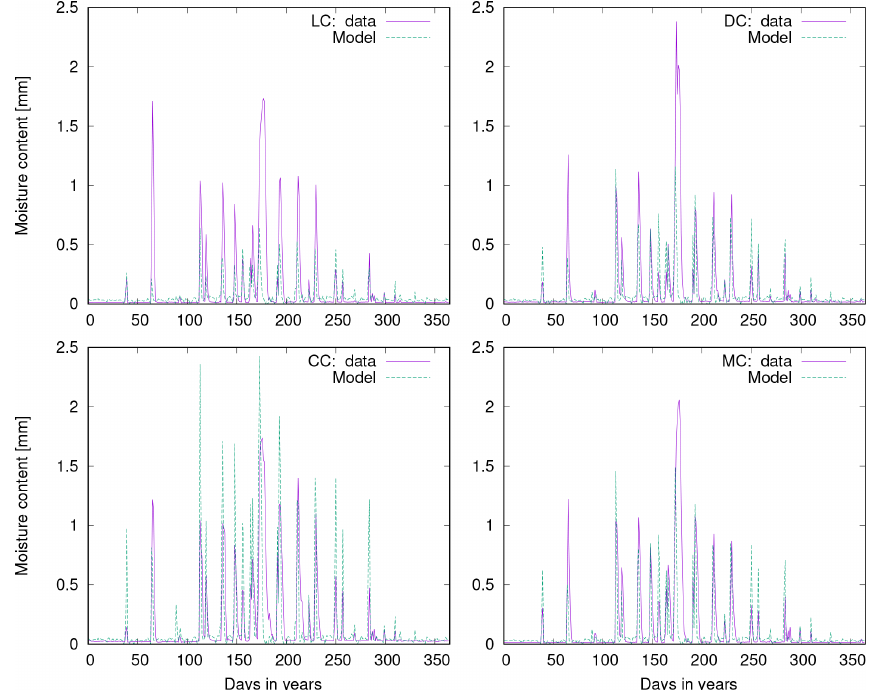
Figure A2. Comparison of measured and simulated moisture content for one field site and four biocrust types at Soebatsfontein. The ab- breviations in the figure legend stand for light cyanobacteria-dominated (LC), dark cyanobacteria-dominated (DC), chlorolichen-dominated (CC), and moss-dominated (MC)